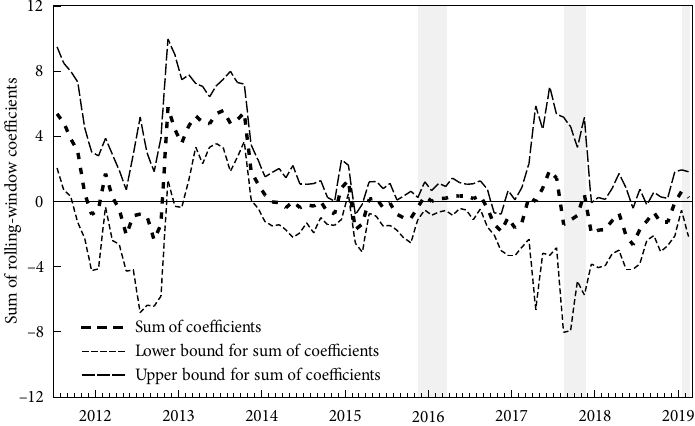
Figure 3. Bootstrap estimates of the sum of the rolling-window coefficients for the impact of PC on